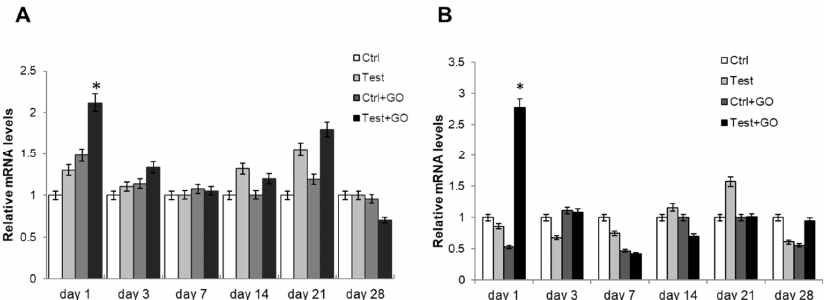
Figure 8. Relative gene expression of ( A ) TGF β and ( B ) BMP2 in DPSCs cultured on Ti discs for 1, 3, 7, 14, 21, and 28 days. Data are expressed as relative to control (calibrator sample, defined as 1). Values represent the means ± SD. Y -axis, fold change. The most representative of three separate experiments is shown.